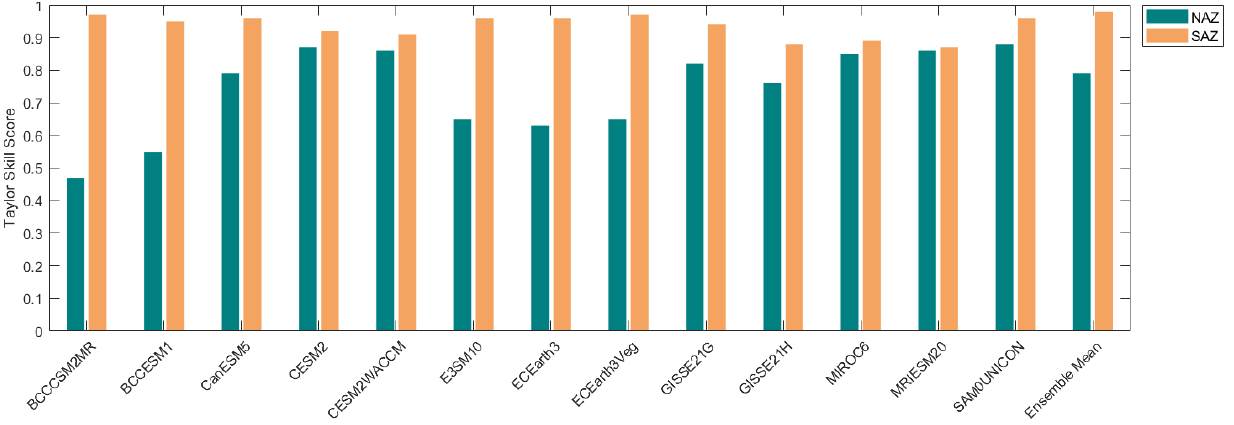
Figure 12. Taylor skill score for northern Amazon (NAZ—green) and southern Amazon (SAZ— orange) for all GCMs compared to CHIRPS observational precipitation for 1981–2014.